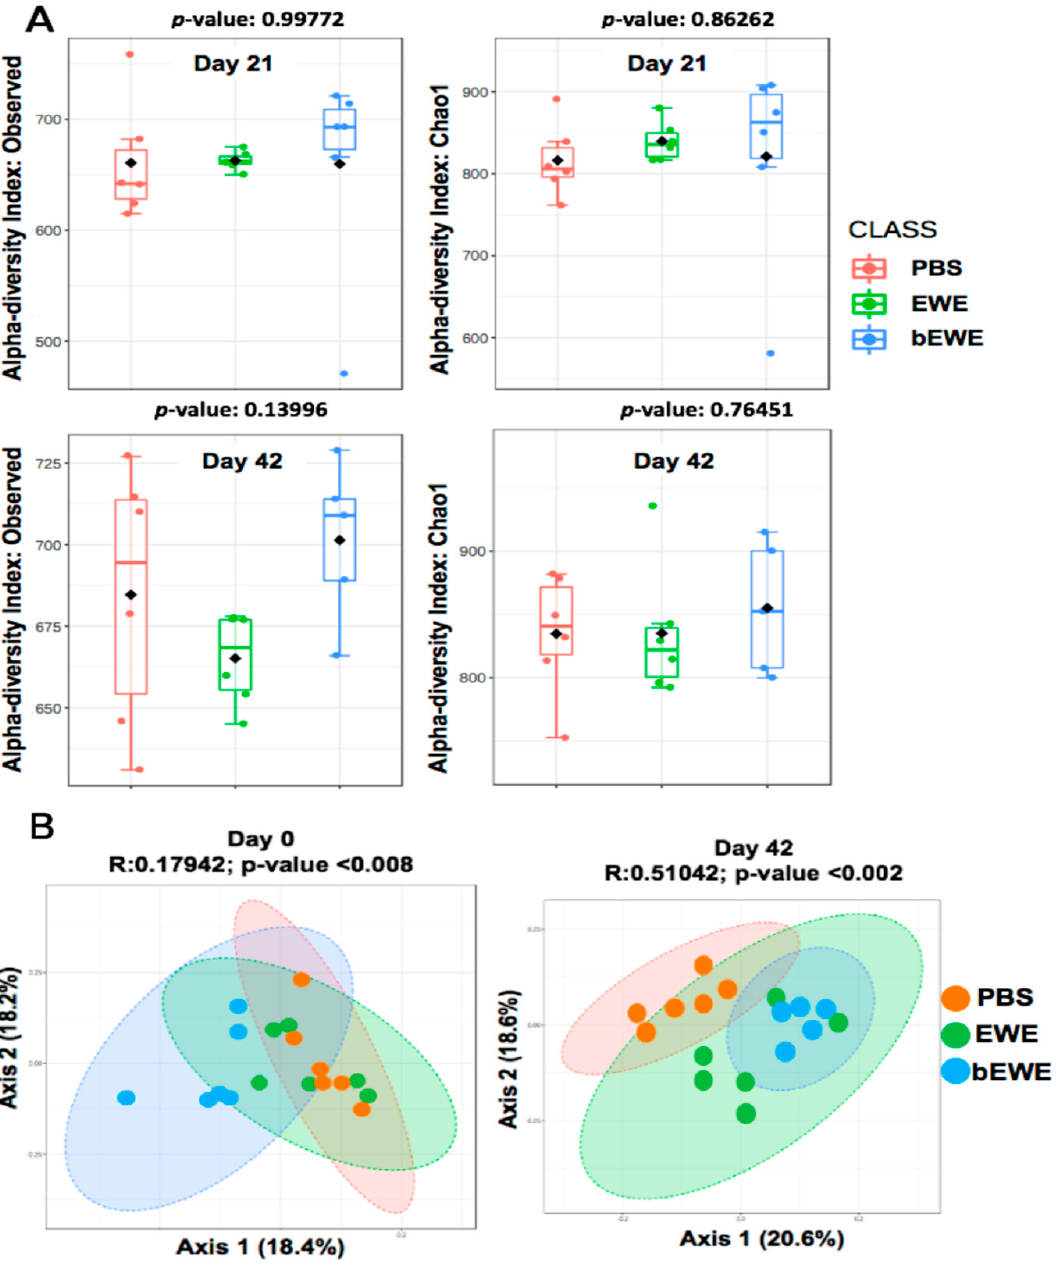
Figure 2. Alpha and beta diversity of gut microbiota in Euglena water extracts and PBS treated mouse feces before (Day 21) and after LLC cell inoculation (Day 42). ( A ) The difference in alpha diversity; measured as observed index and Chao1 index for Day 21 (upper panels in panel A ) and Day 42 (lower panels in panel A ). Box-and-whisker plots show high, low, and median values, with lower and upper edges of each box denoting first and third quartiles, respectively. ( B ) Principal coordinates analysis (PCoA) based on Bray-Curtis dissimilarity representing the difference in gut microbial communities. Each PCoA plot is accompanied by an analysis of similarity (ANOSIM) using an appropriate distance matrix. The R-values closer to zero indicates no difference between groups.